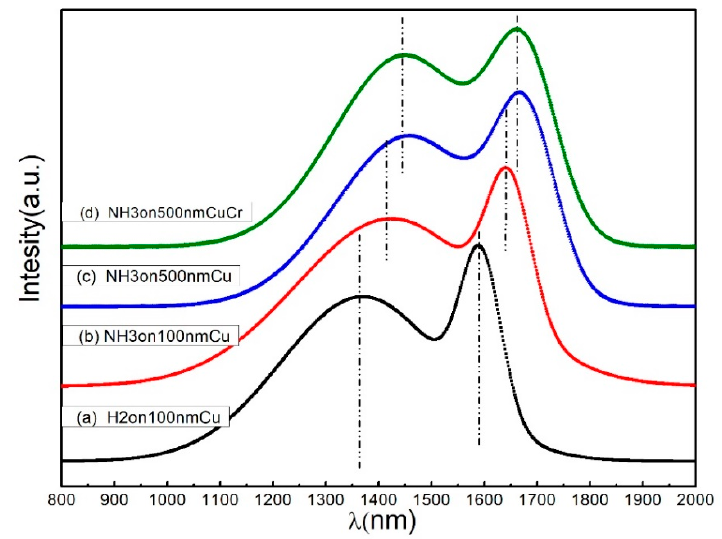
Figure 6. Raman spectra of carbon products synthesis using different reducing gases. ( a ) CNTs on 100 nm Cu in H 2 ; ( b ) CNTs on 100 nm Cu in NH 3 ; ( c , d ) carbon products on 100 nm Cu and Cu-Cr in NH 3.